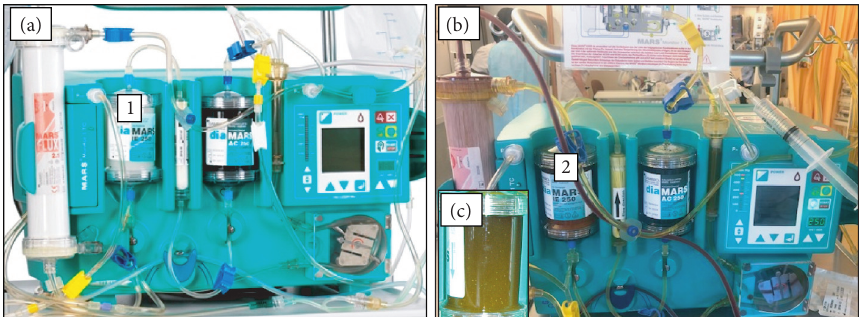
Figure 3: Illustration of the MARS device prior to use (a) and at the end of the initial session (b). The initially colorless diaMARS IE250 adsorber cartridge (1) became dark brown at the end of the procedure due to massive copper deposits (2). (c) A cartridge from a historical case of alcoholic cirrhosis and hepatorenal syndrome under MARS therapy showing, instead, a yellowish brown color due to bilirubin pigments.